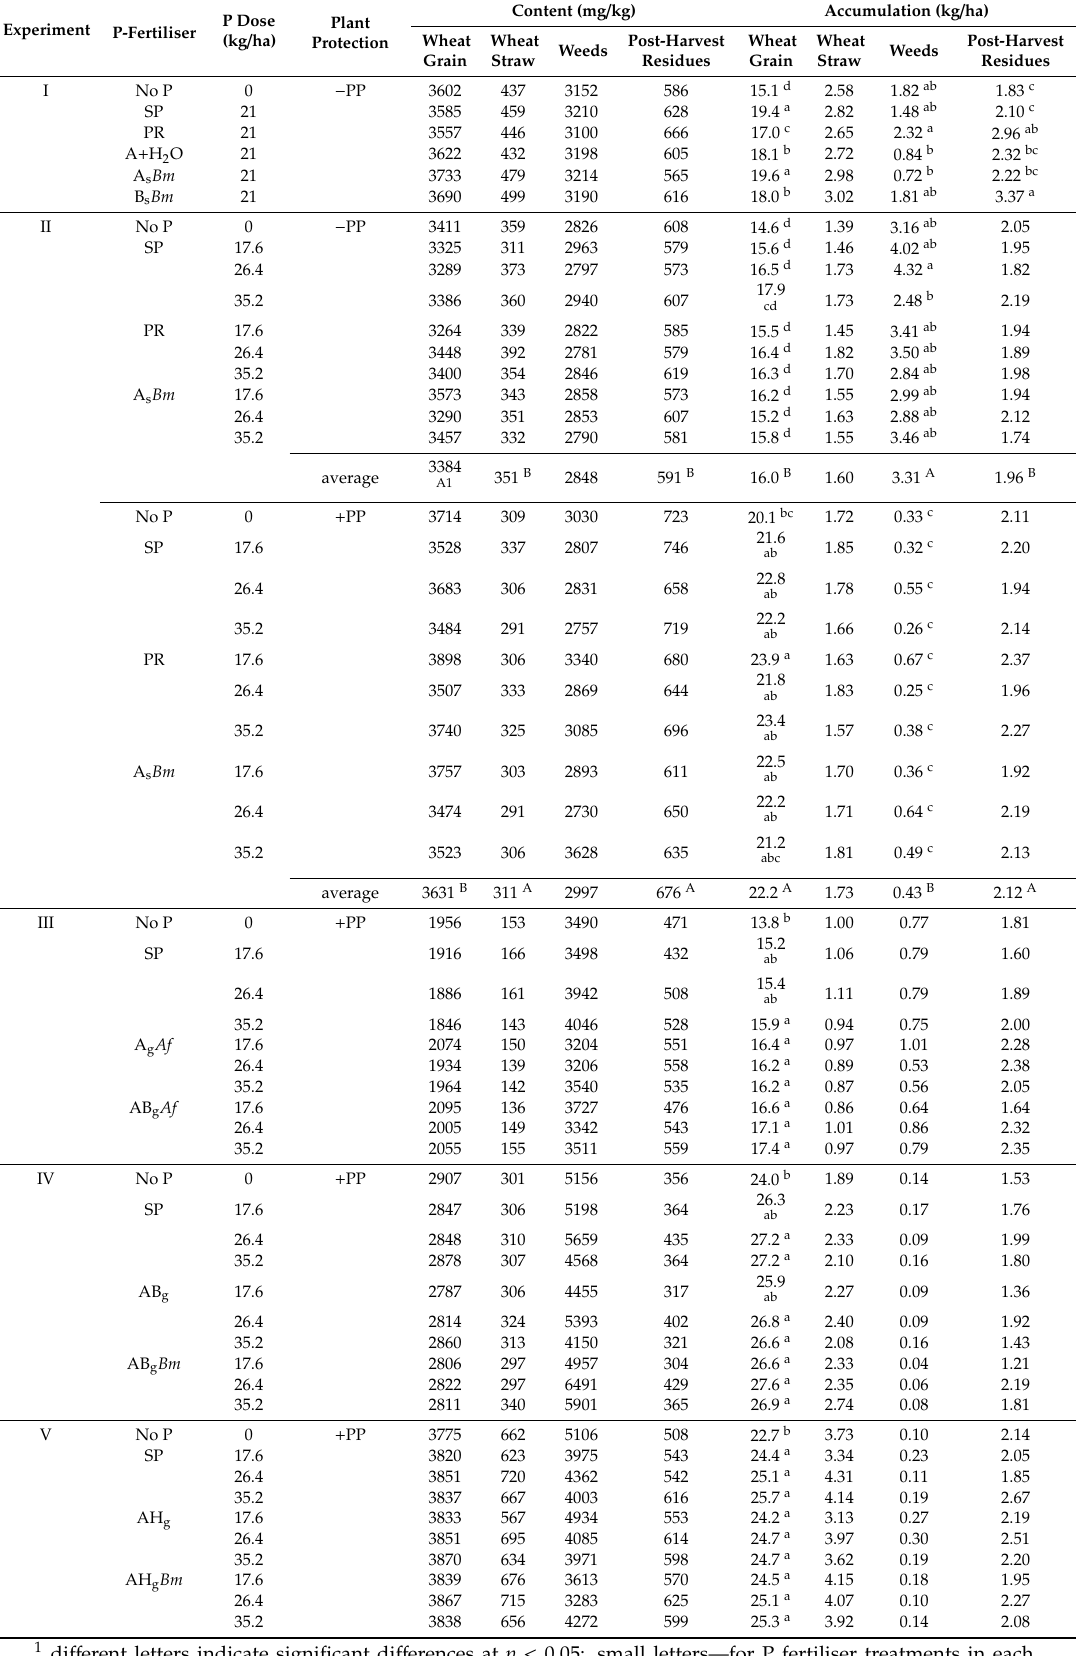
Table 7. Phosphorus content and accumulation in plant biomass from the wheat field. Experiment P-Fertiliser